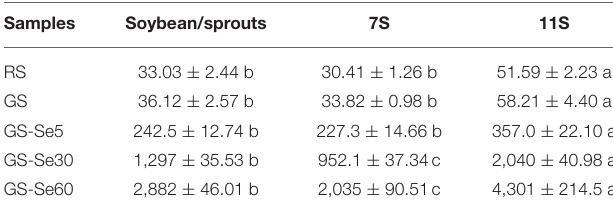
TABLE 1 | Total selenium (Se) concentration in raw soybean (RS), germinated soybean (GS), and germinated soybean with Se biofortification (GS-Se) with different Se treatment concentrations ( µ